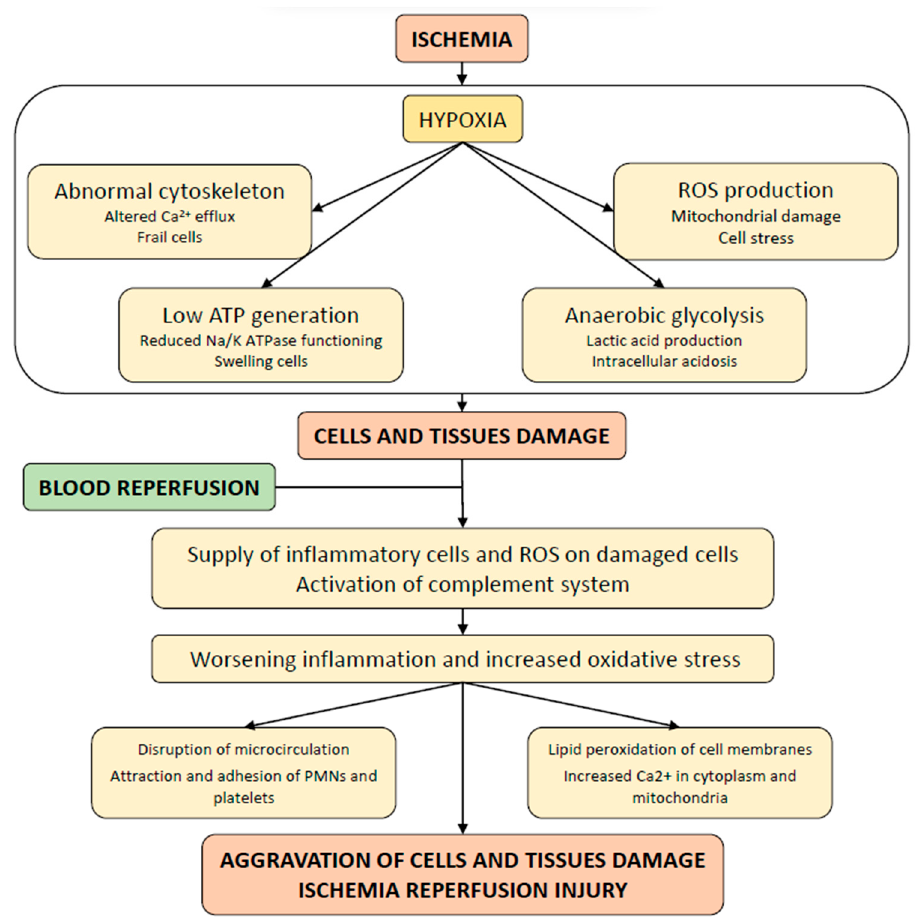
Figure 1. Warm and cold ischemia may produce hypoxia of the kidney tissue. Epithelial tubular cells and endothelial cells are particularly sensitive to ischemia and their damage is proportional to the duration of the ischemia. Hypoxic cells cannot produce an adequate quantity of ATP. The insufficient activity of the ATPase pump creates an im ‐ balance of sodium/potassium exchange with intracellular accumulation of sodium ions.